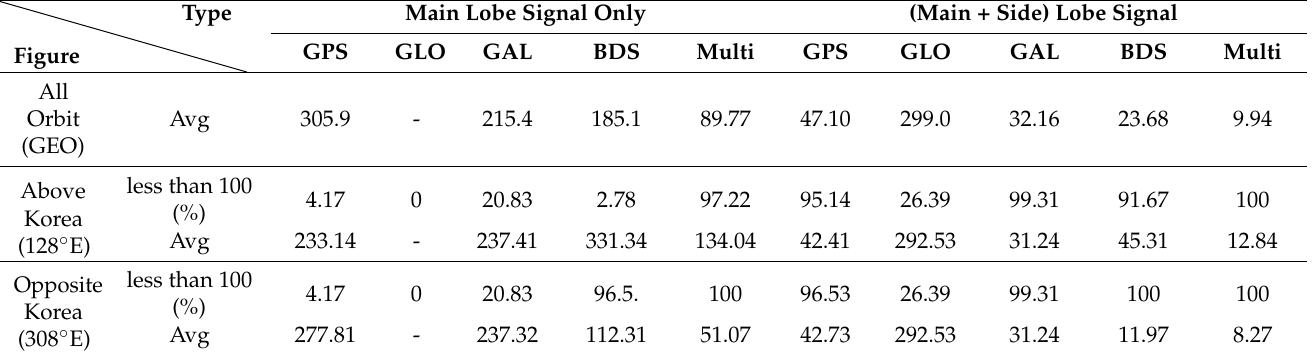
Table 3. Geometry dilution of precision for 24 h in geostationary orbit about longitude. Main Lobe Signal Type Figure Figure Multi